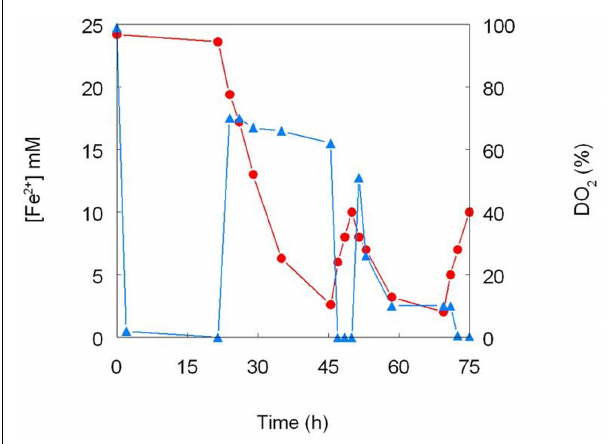
FIGURE 3 | Cycling of iron by a mixed culture of At. ferrooxidans and Acidiphilium SJH. The culture medium (pH 2.0) contained (initially) 25mM ferrous sulfate and 10mM glycerol, and was maintained at 30˚C under controlled aeration. Ferrous iron concentrations are shown in red and concentrations of dissolved oxygen in blue (modified from Johnson et al., 1993).